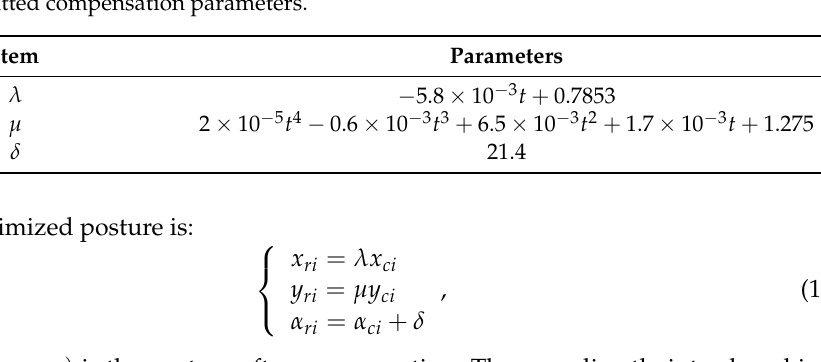
Table 3. The fitted compensation